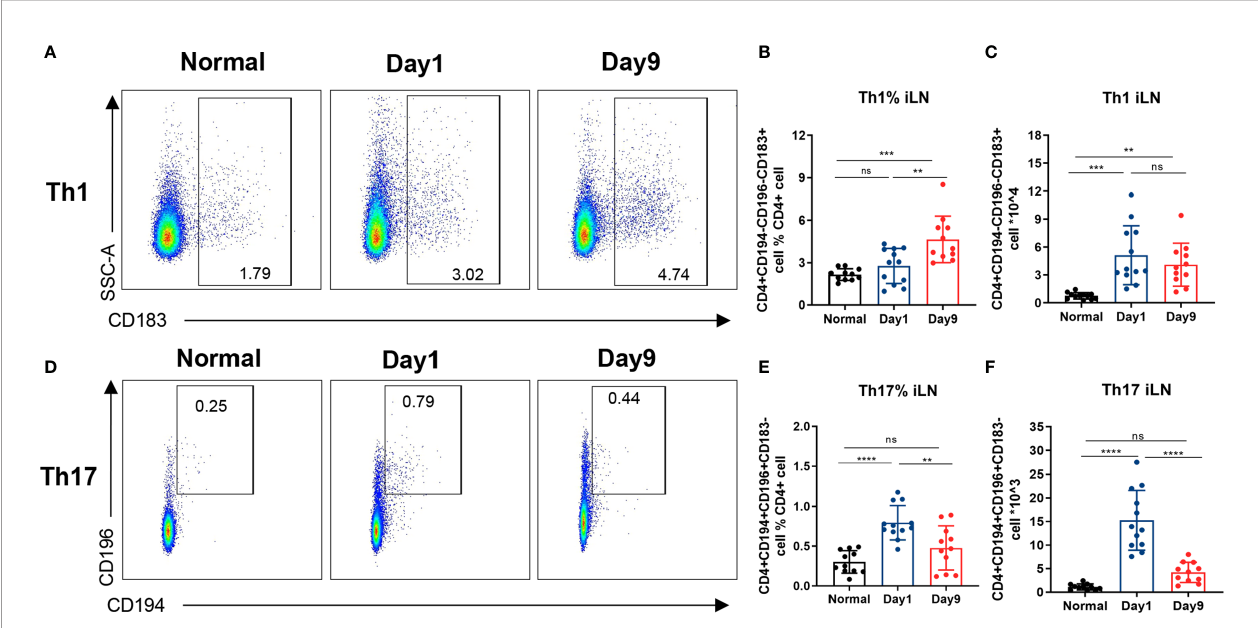
FIGURE 3 | Differential induction of Th1 and Th17 cells in DTHA mice. Relative and absolute levels of Th1 and Th17 cells in draining iLN of normal and DTHA mice on day 1 and day 9 post mBSA challenge analyzed by fl ow cytometry. (A) Representative fl ow cytometry dot plot illustrating relative population of Th1 cells (CD4+ CD194 − CD196 − CD183+). (B, C) Fraction (%) (B) and absolute number (C) of Th1 cells on day 1 and day 9 post mBSA challenge. (D) Representative fl ow cytometry dot plot illustrating relative population of Th17 cells (CD4+CD194+CD196+CD183 − ). (E, F) Fraction (%) (E) and absolute number (F) of Th17 cells on day 1 and day 9 post mBSA challenge. Data is presented as mean ± SD from two independent experiments with at least fi ve mice in each group per experiment. Statistical signi fi cance was calculated by ANOVA with Tukey multiple comparison test (**p < 0.01, ***p < 0.001, ****p < 0.0001, ns: p >